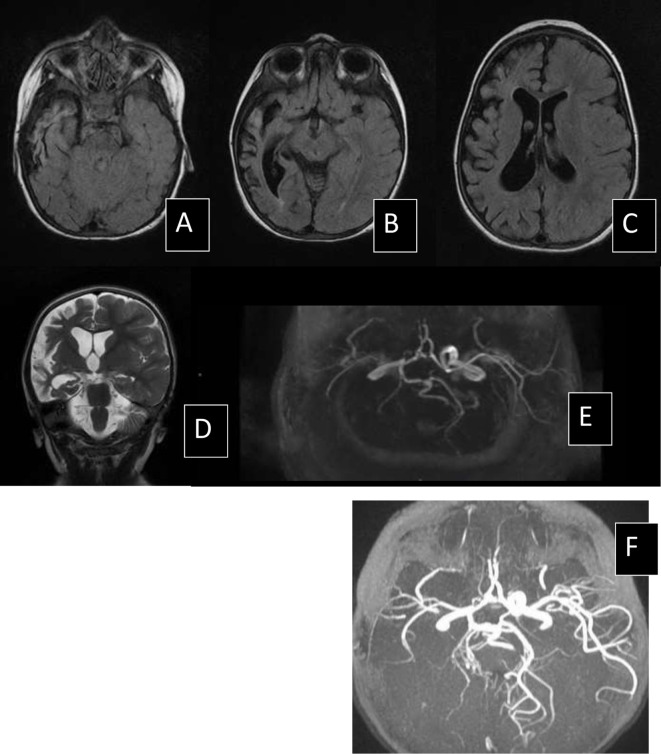
MRI scan of patient N09, 1 year after stroke secondary to cerebral VZV vasculitis. Right hemisphere atrophy on axial FLAIR sequence (A–C) and coronal T2 sequence (D) and stenosis of internal carotid artery and posterior cerebral arteries in vascular sequences Time of flight (TOF) angiography (E, F).